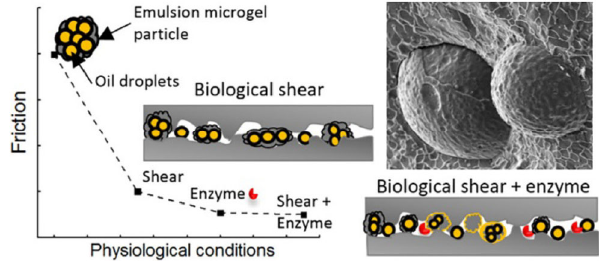
Fig. 15 The lubrication performance of emulsion microgel par- ticles under physiological conditions. Reproduced with permission from Ref. [167]. © American Chemical Society,